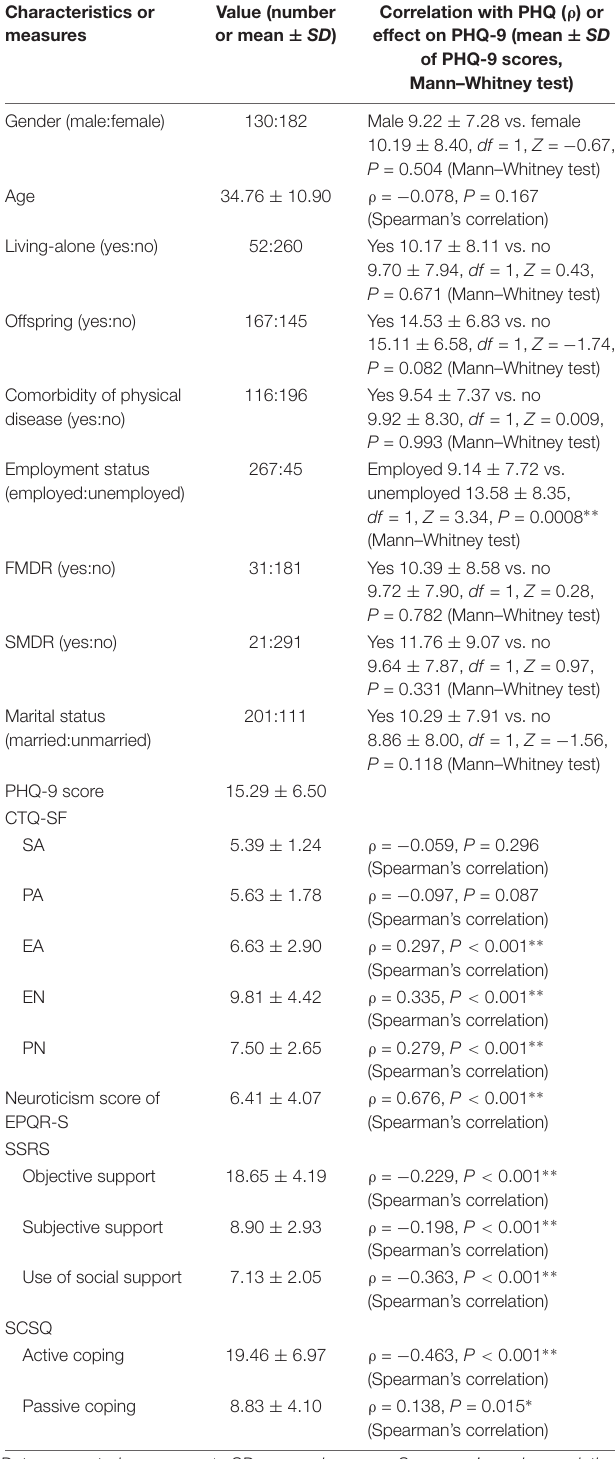
TABLE 1 | Characteristics, CTQ-SF, EPQR-S, SSRS, SCSQ, and correlation with PHQ-9 or effects on PHQ-9 in the participants. Characteristics or Value (number Correlation with PHQ ( ρ ) or measures or mean ± SD ) effect on PHQ-9 (mean ±